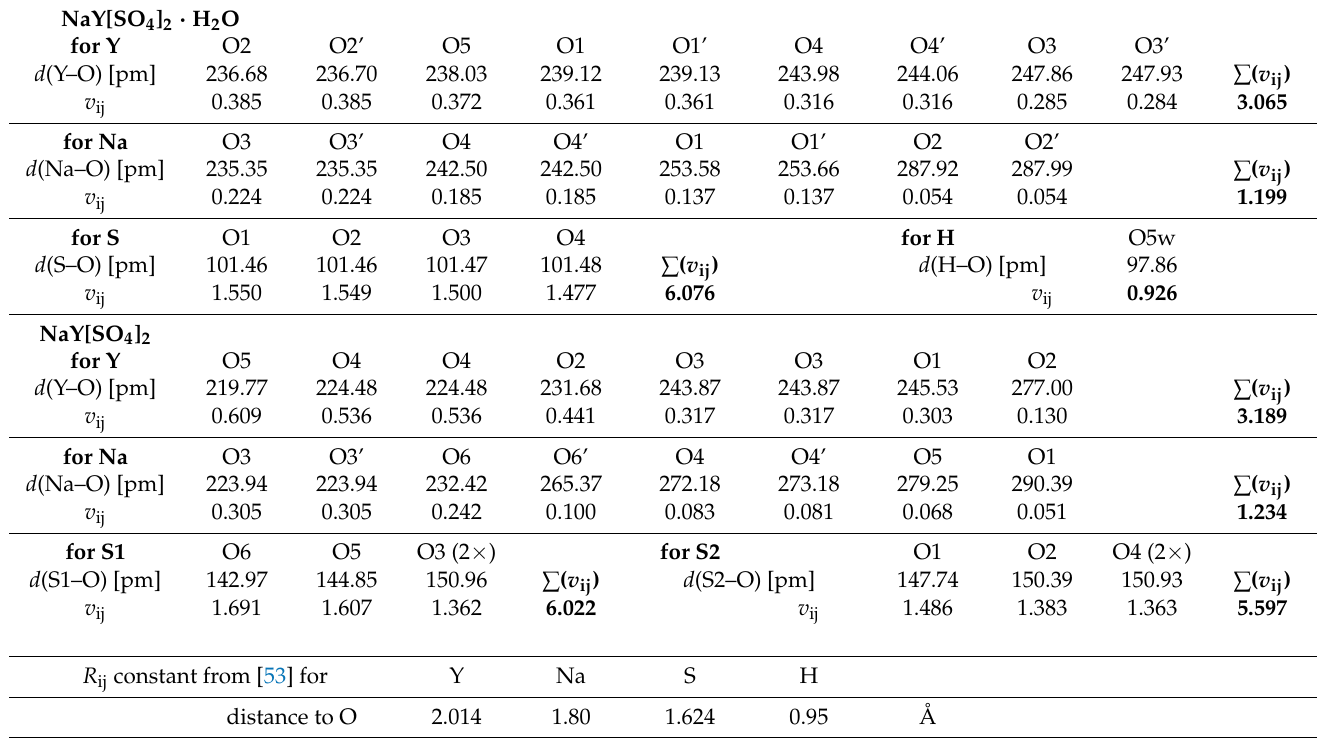
Table 4. Results of the bond-valence calculations for NaY[SO 4 ] 2 · H 2 O and NaY[SO 4 ] 2 .